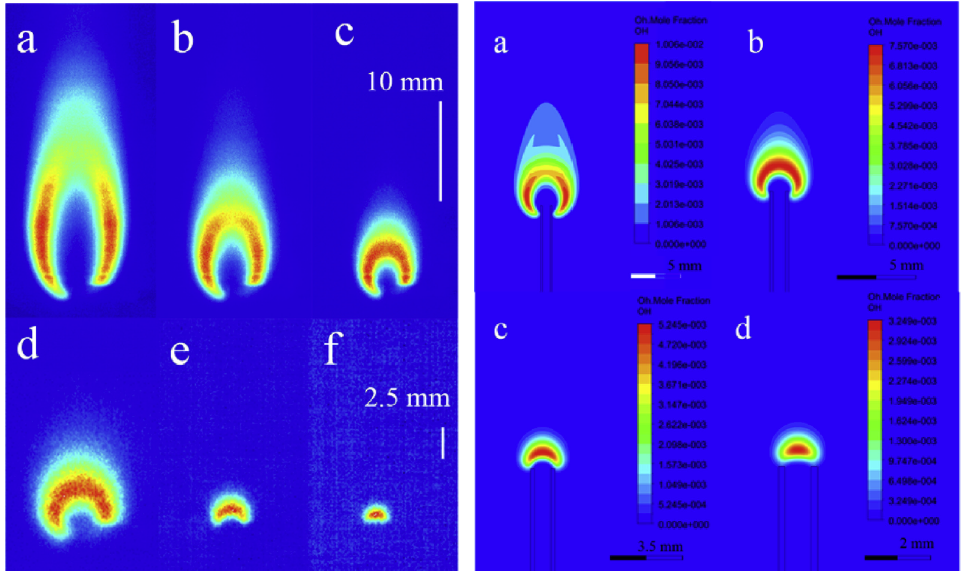
Figure 12. Experimental and numerical study of the thermal interaction with solid micro tube in non-premixed hydrogen jet flames by Zhang et al. [23]. Left : OH-PLIF images of hydrogen micro-jet flames at different fuel flow velocities: ( a ) 10 m/s; ( b ) 5 m/s; ( c ) 2.5 m/s; ( d ) 1 m/s; ( e ) 0.35 m/s; ( f ) 0.17 m/s; Right : Computational OH mole fractions of hydrogen micro-jet flames at different fuel flow velocities: ( a ) 2.5 m/s; ( b ) 1 m/s; ( c ) 0.35 m/s; ( d ) 0.17